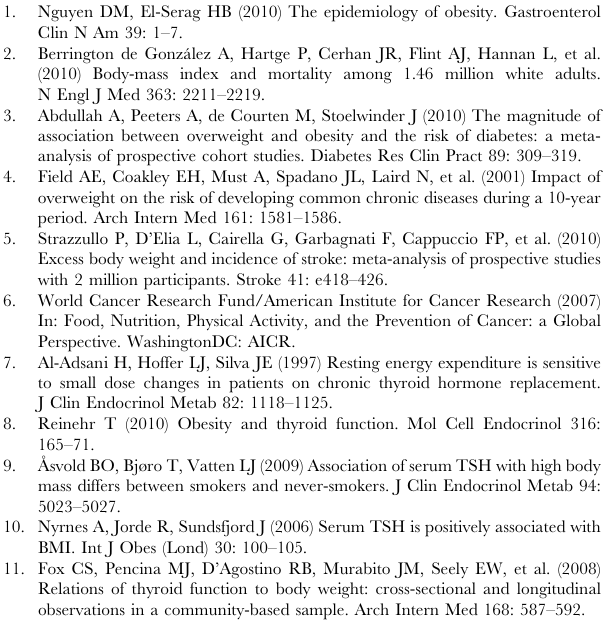
Figure S2 Association between waist circumference and mean TSH levels in euthyroid men (n =1,623) and euthyroid women (n= 1,491), NHANES 2007–2008. Mod- els used restricted quadratic splines and were adjusted for age, smoking status, race/ethnicity, and alcohol intake. Figure S3 Association between BMI and mean fT 3 levels in euthyroid men (n= 1,623) and euthyroid women (n= 1,491), NHANES 2007–2008. Models used restricted quadratic splines and were adjusted for age, smoking status, race/ethnicity, and alcohol intake. Figure S4 Association between waist circumference and mean fT 3 levels in euthyroid men (n= 1,623) and euthyroid women (n= 1,491), NHANES 2007–2008. Mod- els used restricted quadratic splines and were adjusted for age, smoking status, race/ethnicity, and alcohol intake. Table S1 Distribution of thyroid measures in men (n= 2,910) and women (n= 3,025) ages 20 + , NHANES 2007–2008. Table S2 Quartile cutpoints for anthropometric variables